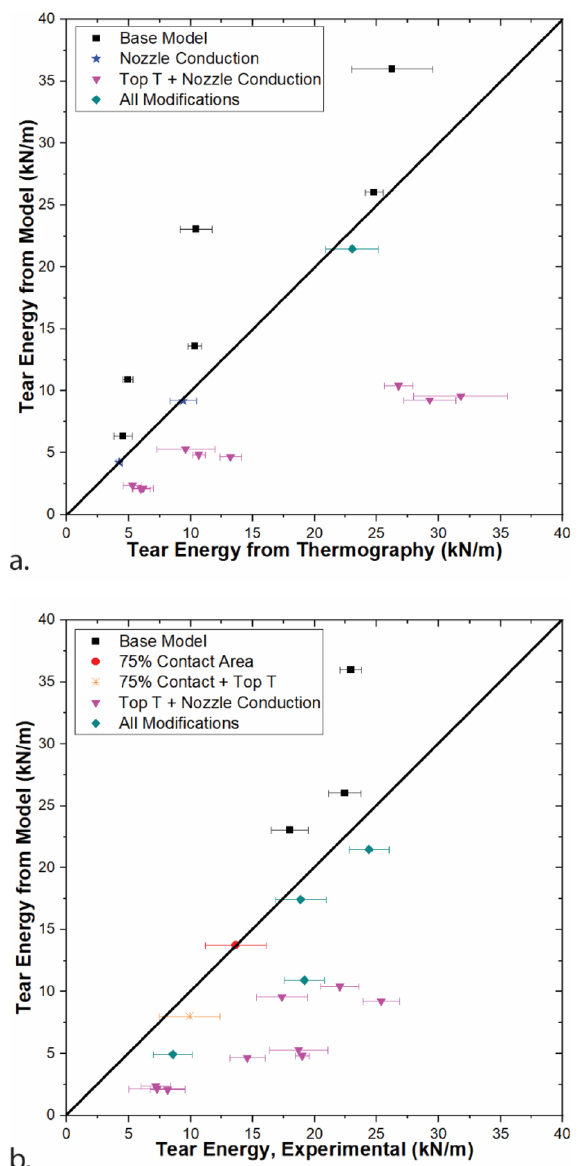
Figure 10. Models that best predict tear energy ( a ) calculated from thermography and ( b ) from experimental measurements of tear energy. Thermography and tear energy data are from Ref. 17 . Error bars represent standard